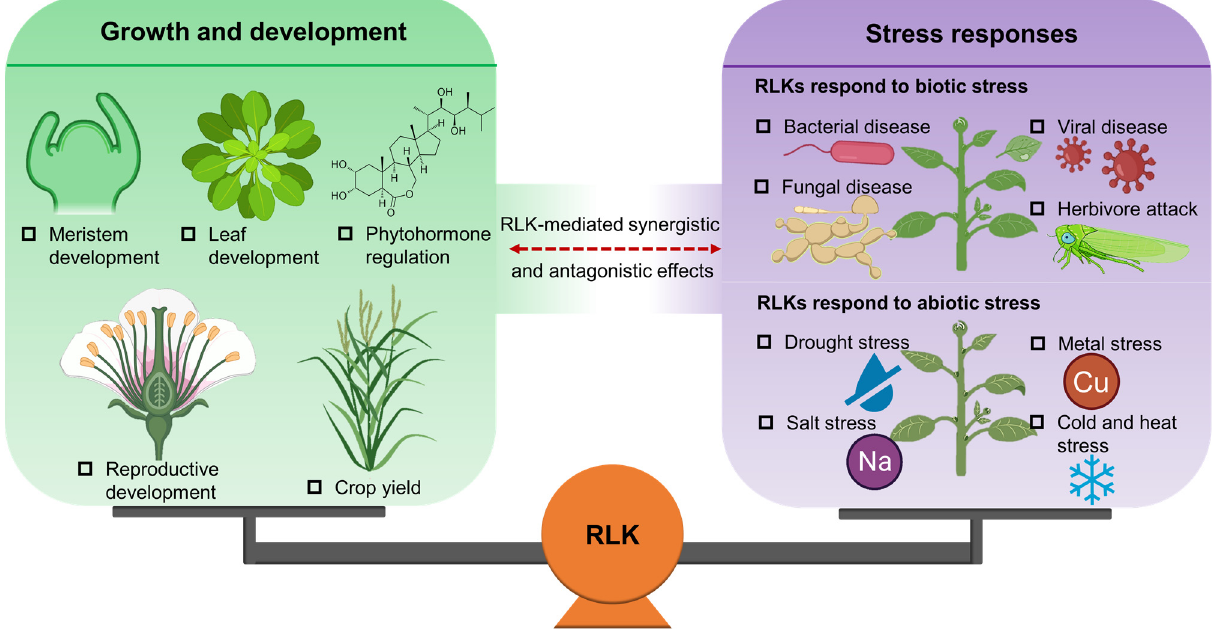
Figure 1. Schematic diagram of receptor-like protein kinase (RLKs) in balancing plant growth and stress responses.